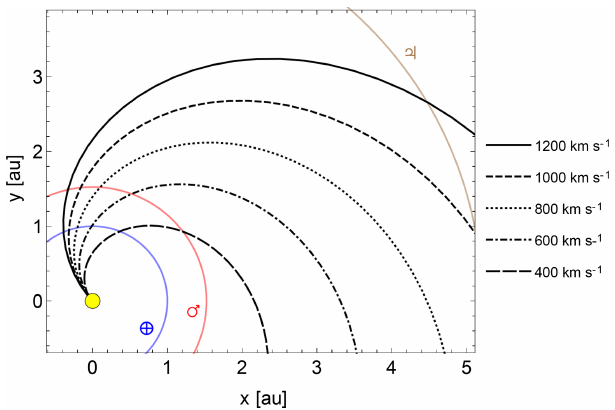
Figure 2. Streamlines in the Parker spiral model of interplanetary magnetic field around the Sun (a filled circle in yellow) in the helio- spheric ecliptic plane up to 5 astronomical units (au) under different conditions of the solar wind speed. The orbit of the Earth is marked by a blue curve at a radius of 1au, that of Mars by a red curve (1.5au), and that of Jupiter by a green curve